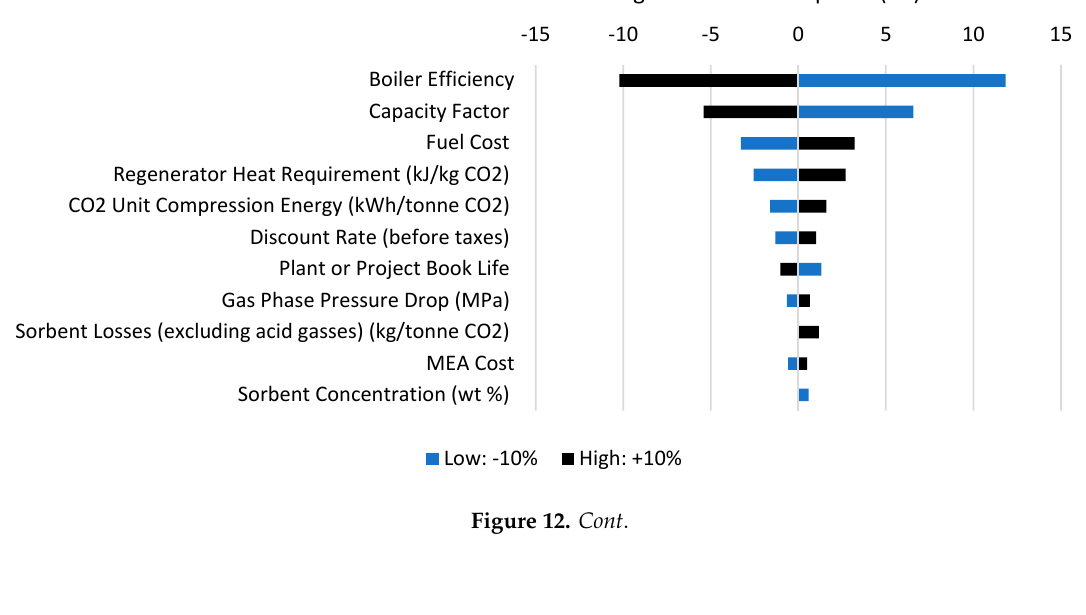
Figure 12. Sensitivity analyses of PC and IGCC powerplants running on pelletized pine. The bars in black represents results from increasing the input variable by 10%. 4. Discussion The maximum 90% CO 2 sequestration scenarios in Figure 9 and Figure 10 show capture of up 181 million tonnes CO 2 per year in 2020 and up to 737 million tonnes CO 2 per year in 2040. These results are within the range of CO 2 sequestration potential in the US that is constrained for colocation, storage, and injectivity (100–110 million tonnes CO 2 and 360–630 million tonnes CO 2 in 2020 and 2040, respectively) and the total potential (370–400 million tonnes CO 2 and 1040–1780 million tonnes CO 2 in 2020 and 2040, respectively) reported by Baik, Sanchez, Turner, Mach, Field, and Benson [8]. Differences are to be expected, as Baik et al. constrain biomass resources to those within (i.e., over) sequestration basins, whereas the present analysis allows for use of biomass resources from outside sequestration basins to the extent that CO 2 emissions from transporting biomass do not exceed sequestration benefits, and associated transportation costs are incurred. Costs shown above expressed as CAC range from $42 to $137 per tonne CO 2 , which are within or below the $100 to $200 per tonne CO 2 reported by the IPCC ([4], Figure 4.2). The results illustrate cost trends. Firstly, feedstock pelletization in the IGCC 2040 scenario results in a CAC about 6% cheaper. This is due to cost savings in transportation of the feedstock and higher energy density of the fuel because of lower moisture content of the feedstock. Secondly, as we